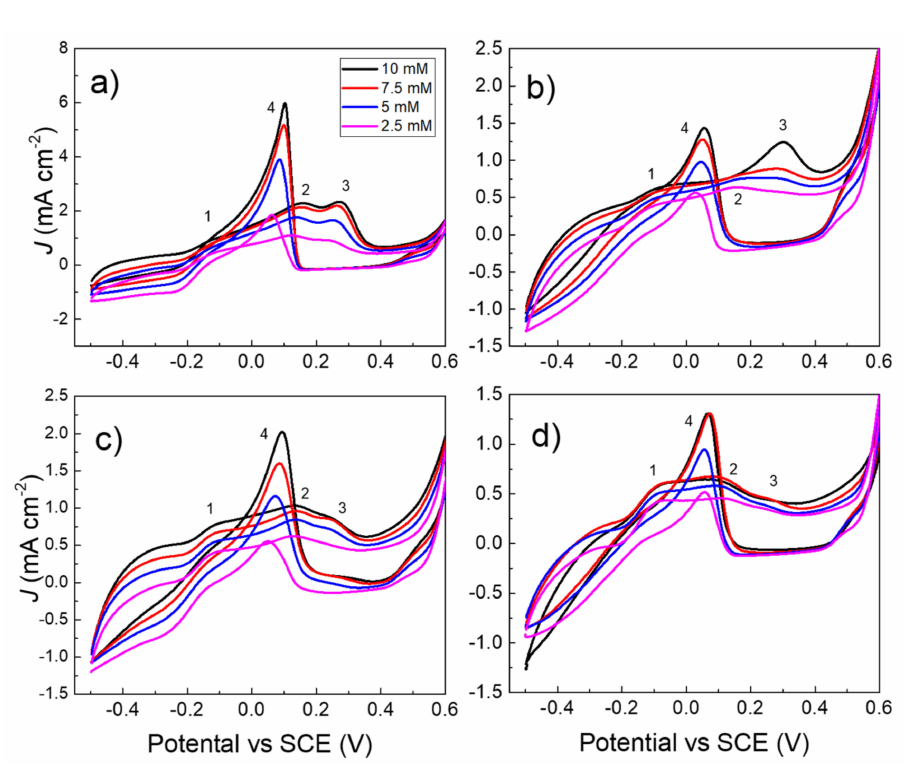
Figure 3. Cyclic voltammograms of glucose 2.5, 5, 7.5, and 10 mM obtained by: ( a ) gold nanoporous; ( b ) 8 nm 300 ◦ C; ( c ) 17 nm 400 ◦ C; ( d ) laser dewetted at fluence of 0.5 J cm − 2 . The 1–4 numbers refer to the main electrochemical processes. Condition: scan rate 20 mV s − 1 ; supporting electrolyte: NaOH 0.1